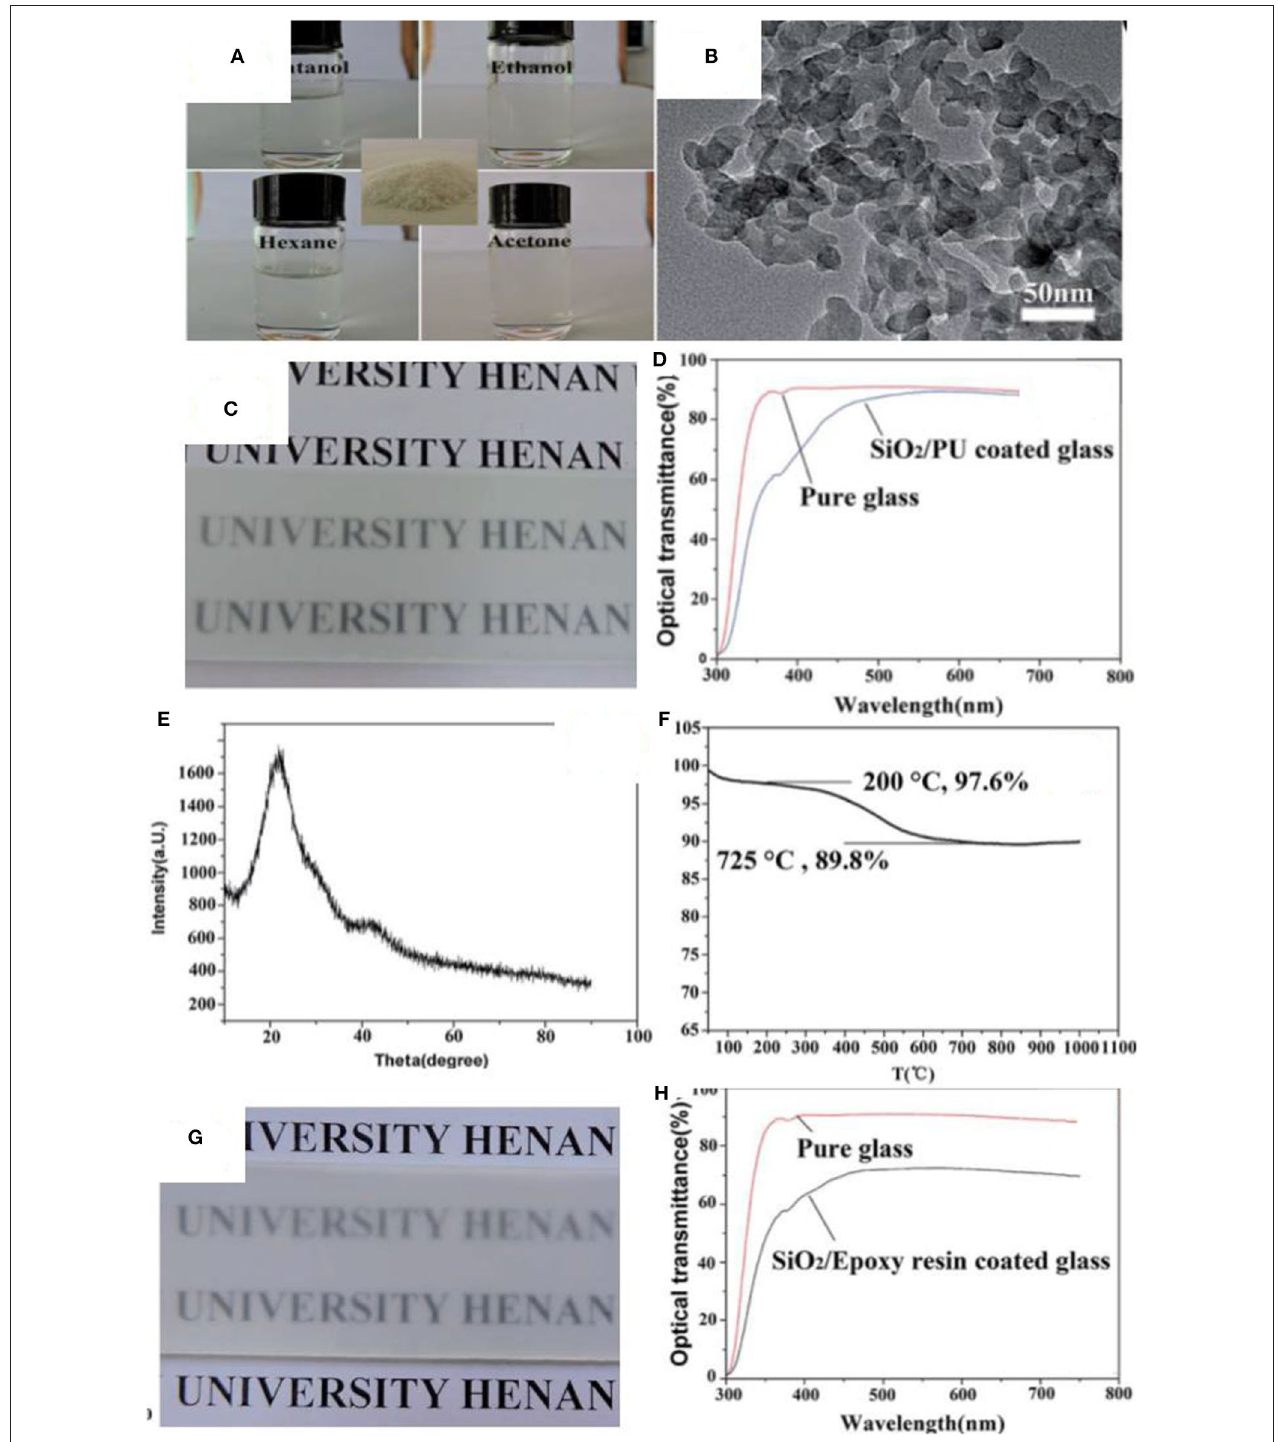
FIGURE 2 | (A) Digital images showing silica nanoparticles dispersion in different solvents, the inset shows the silica powder. (B) Transmission electron microscopy (TEM) of silica nanoparticles. (C) Digital image showing the coating of silica/polyurethane on glass. (D) Difference in transmittance of glass slide before and after coating silica/polyurethane. (E) X-ray diffraction spectrum of silica nanoparticles. (F) Thermal analysis of the silica nanoparticles. (G) Digital images showing the coating of silica/epoxy resin on glass. (H) Difference in transmittance of glass slide before and after coating of silica/epoxy. Adapted from Zhi et al. (2017). With permission from the Royal Society of Chemistry,